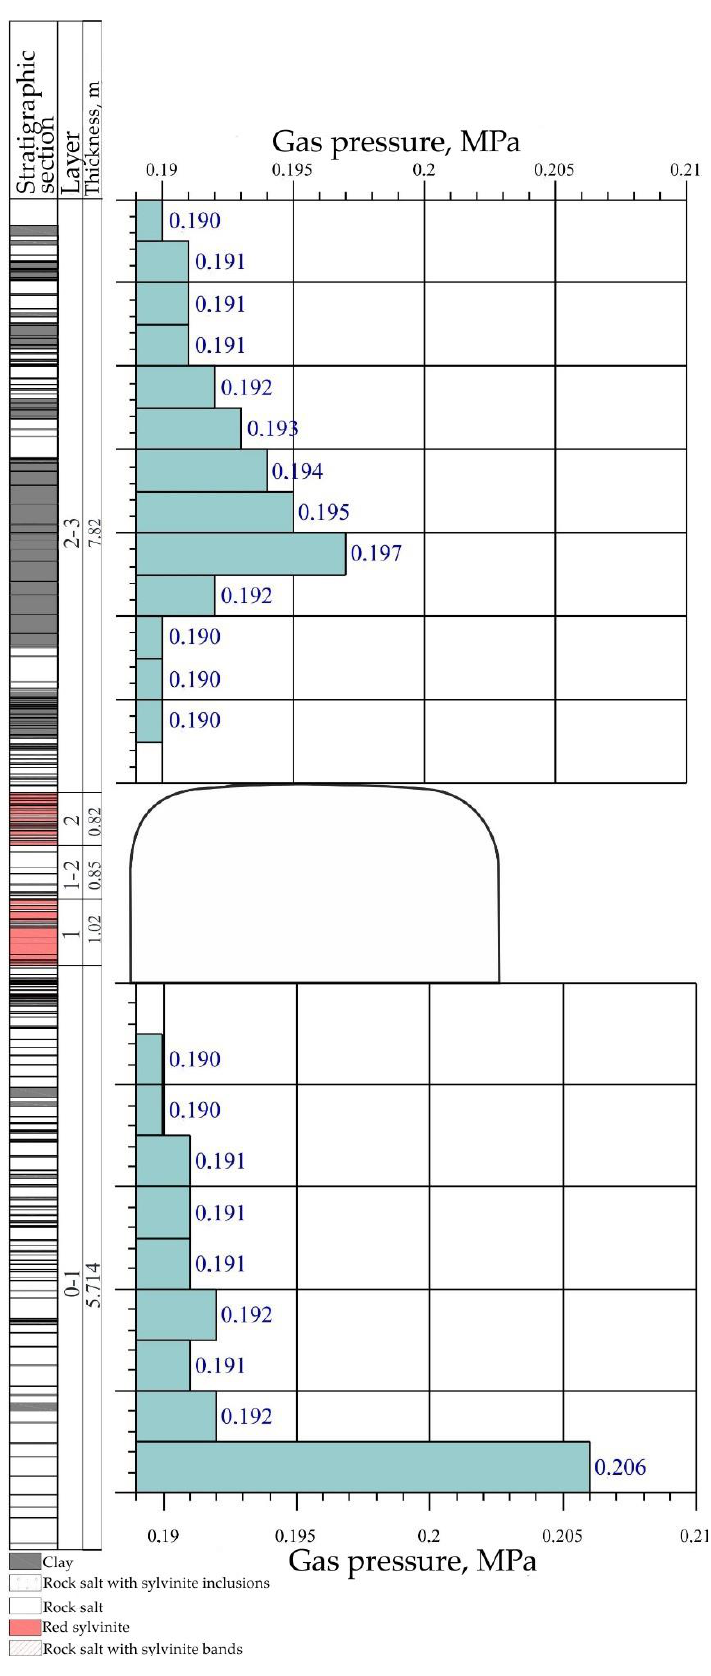
Figure 3. The gas pressure of the camera roof and soil with the underworking.